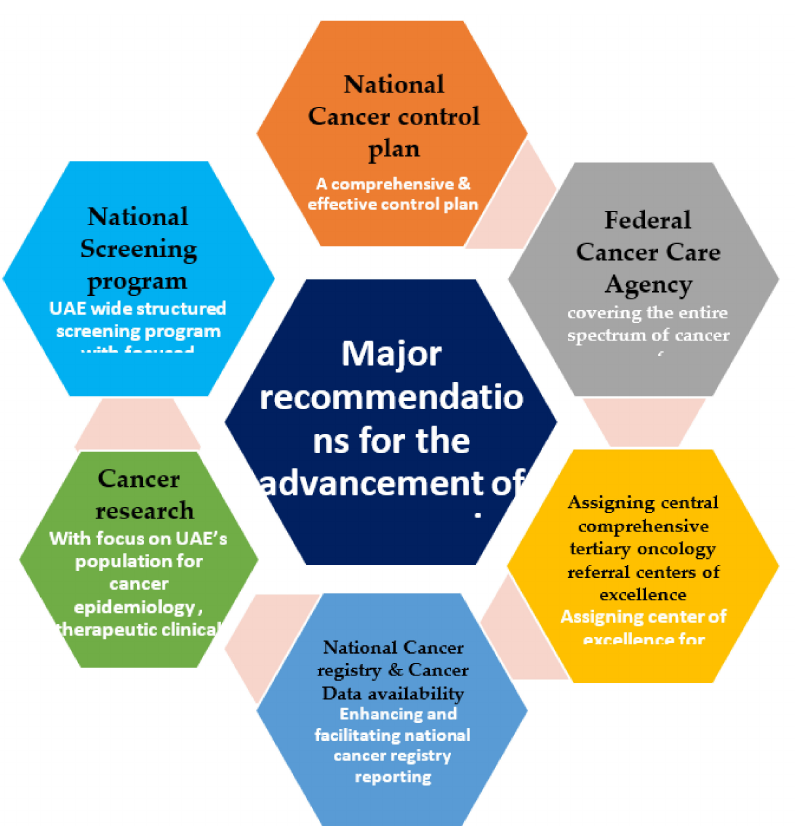
Figure 4. Major recommendations for the advancement of cancer care in the